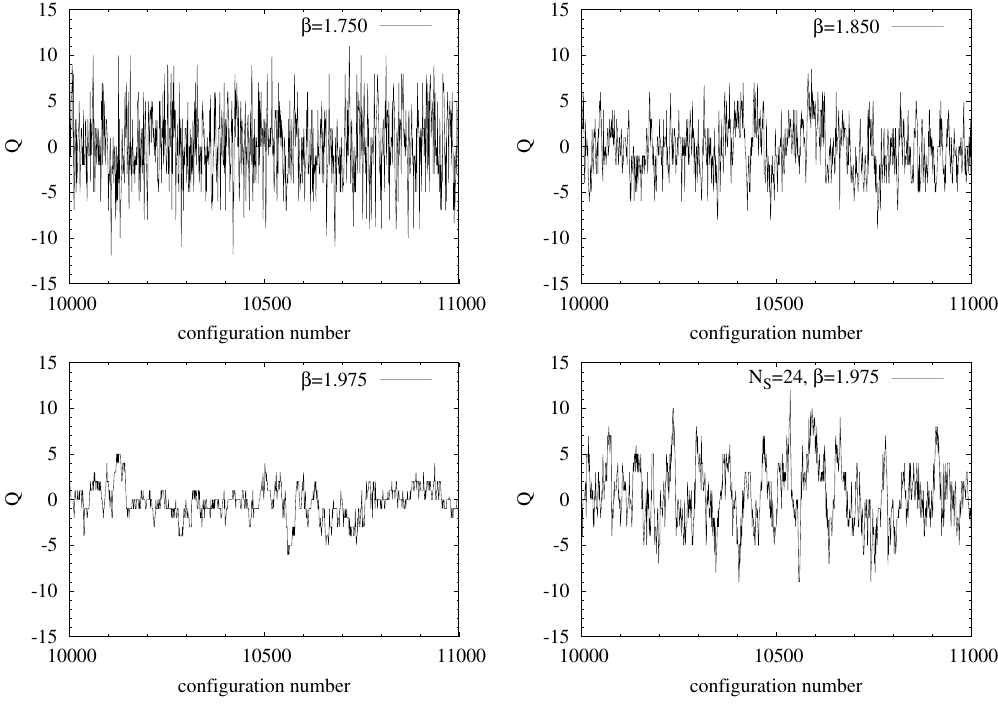
Figure 6 . Monte Carlo history of Q at four